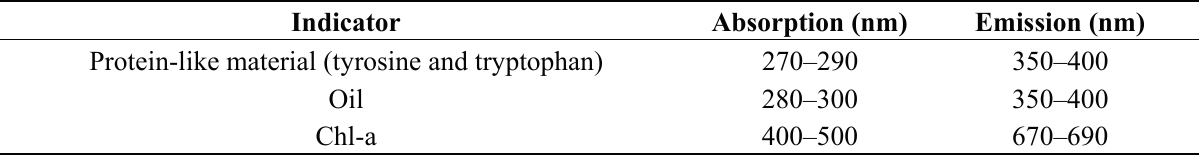
Table 1. Absorption and emission bands of some important indicators of the ecological status of coastal waters.